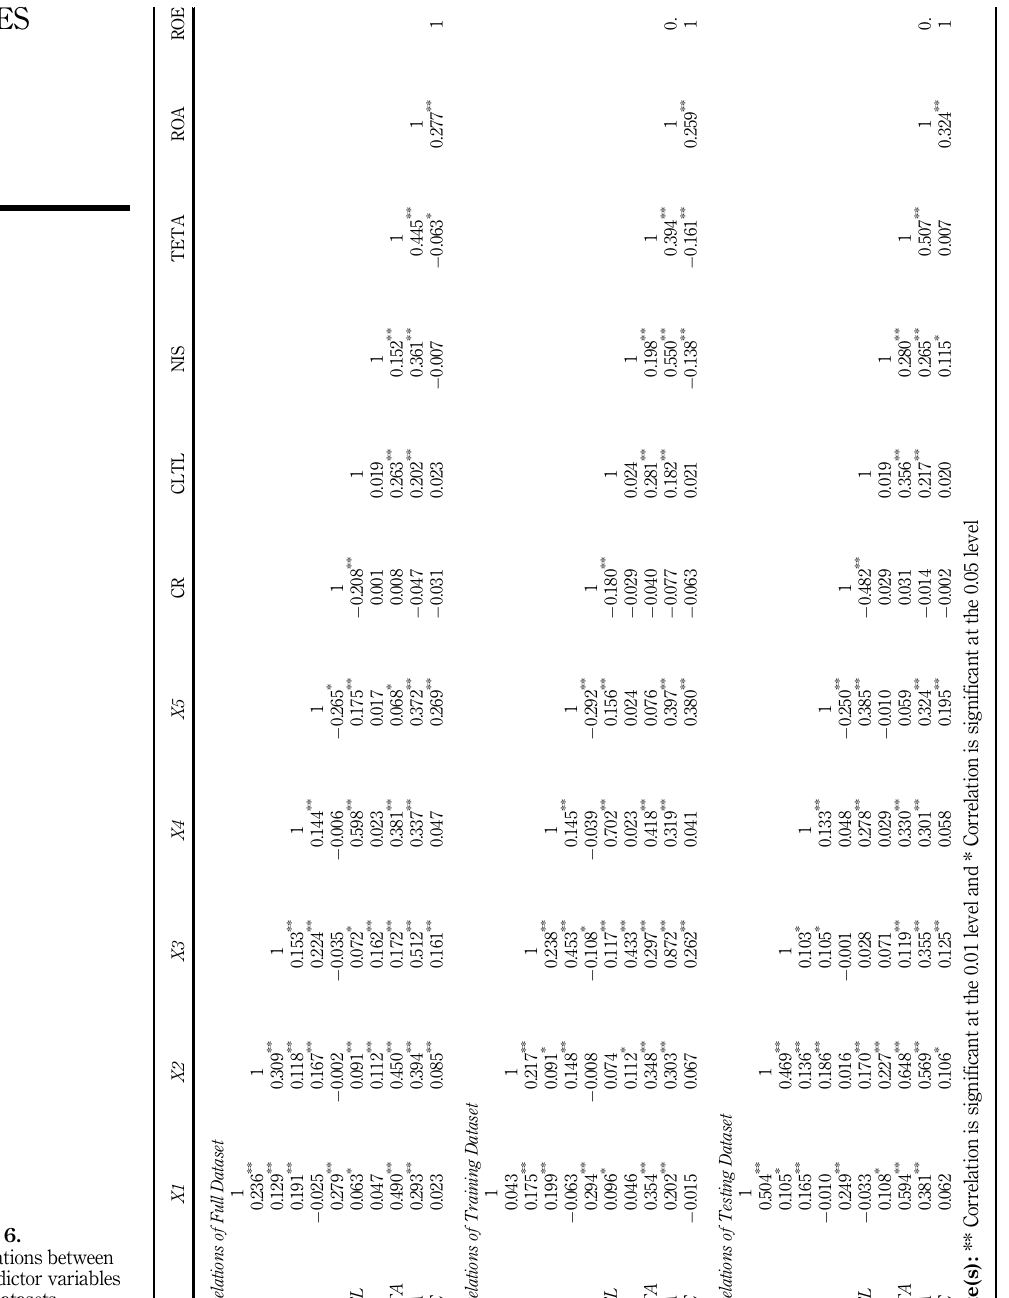
Table 6. Correlations between all predictor variables of all